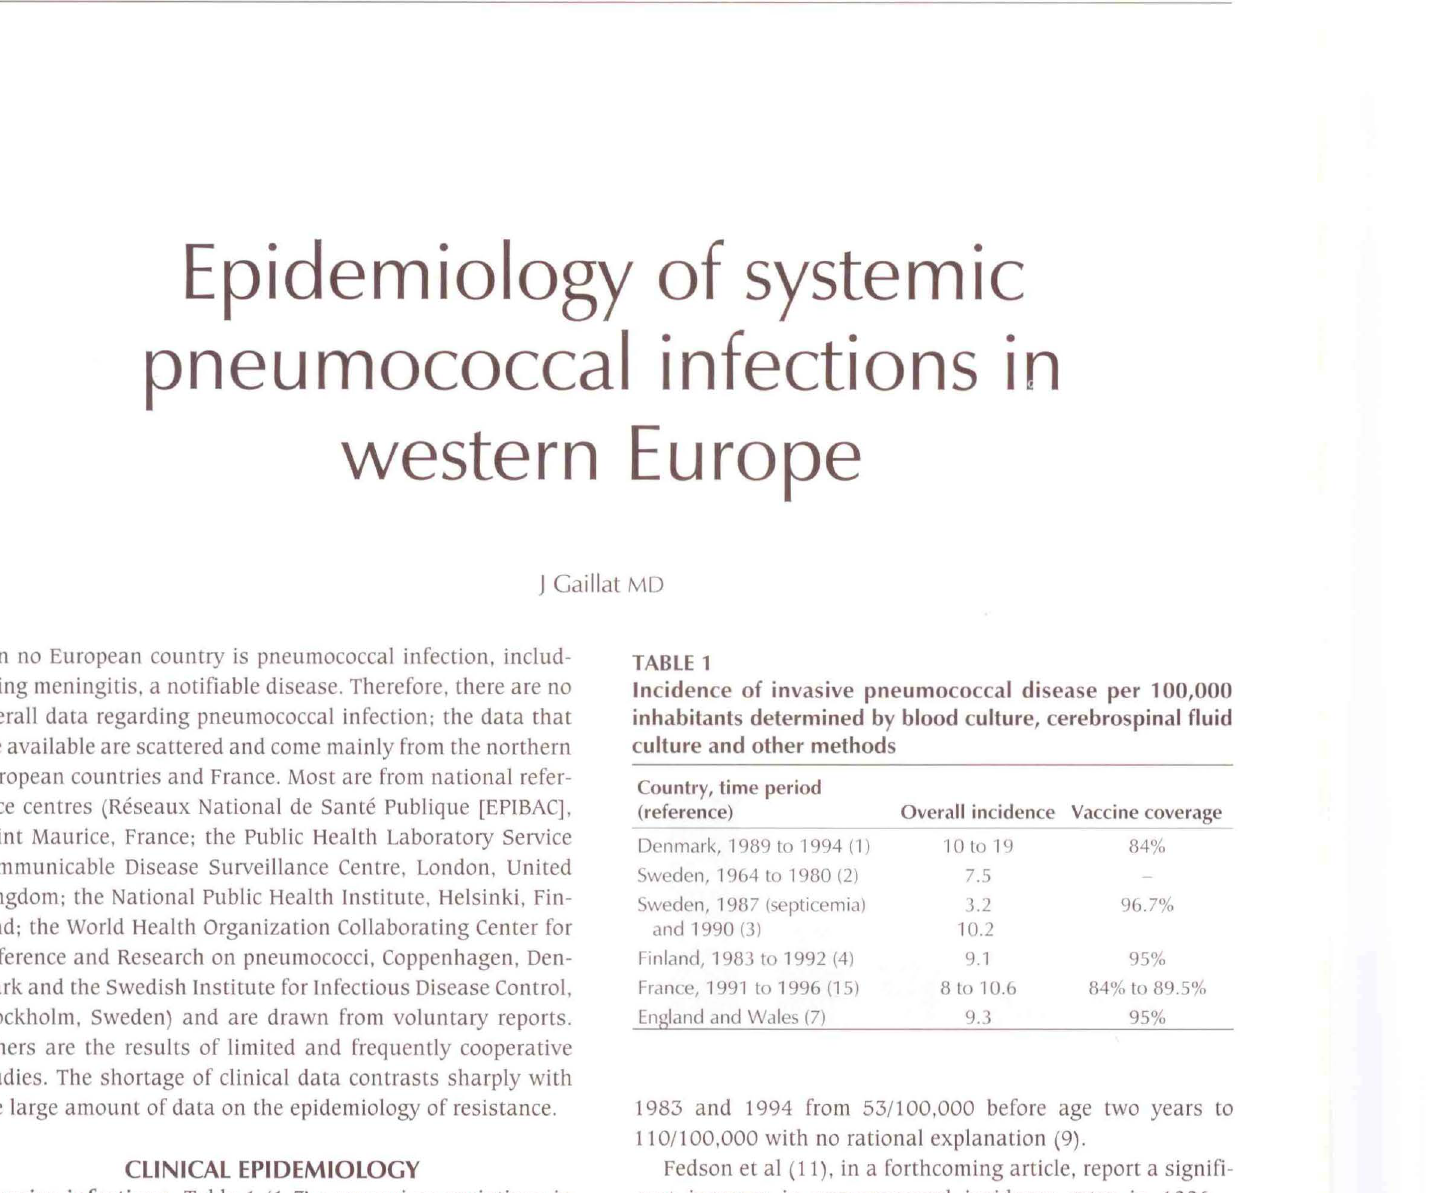
Invasive infections: Table I ( 1-7) summarizes variations in incidence of invasive pneumococcal disease per 100,000 in